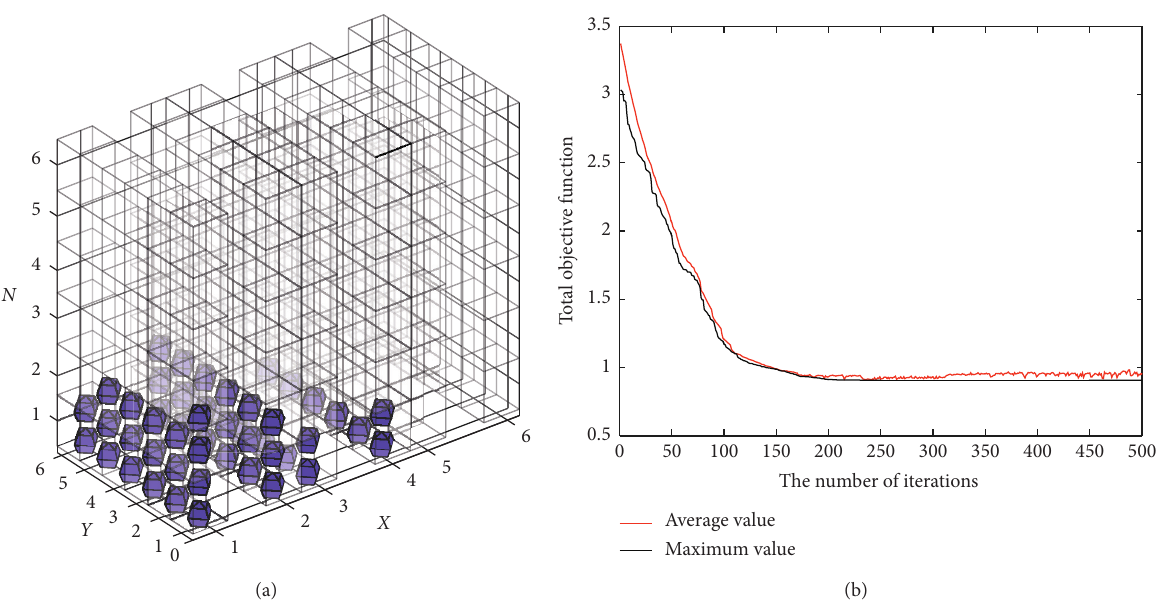
Figure 7: (a) The optimized cargo position stereogram. (b) The algorithm of the comparison iteration